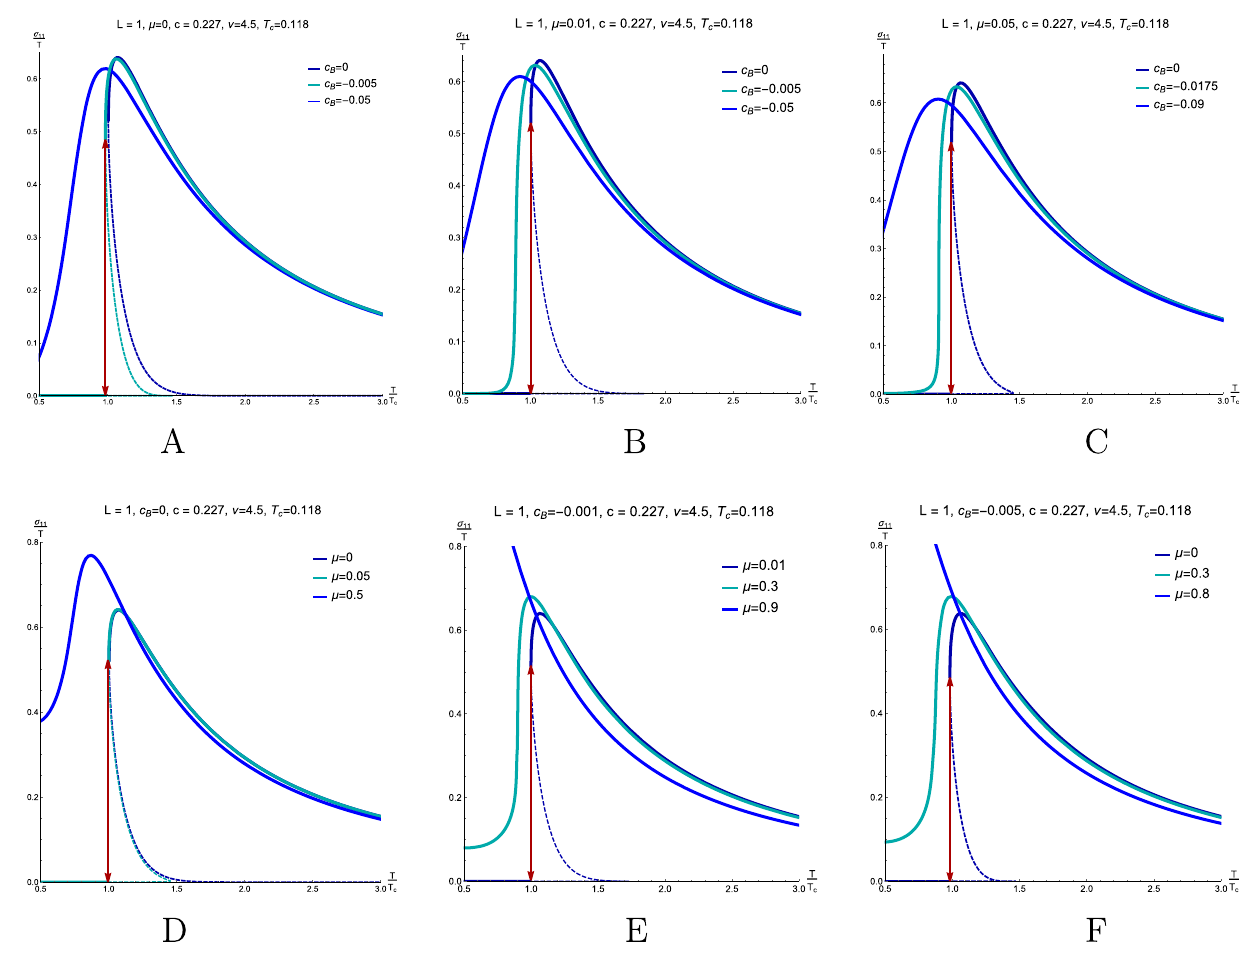
Fig. 8 Thedependenceof σ 11 / T onthenormalizedtemperature T / T c for different values of magnetic field’s parameter c B and μ = 0 ( A ), μ = 0 . 01 ( B ) and μ = 0 . 05 ( C ), and for different values of chemical